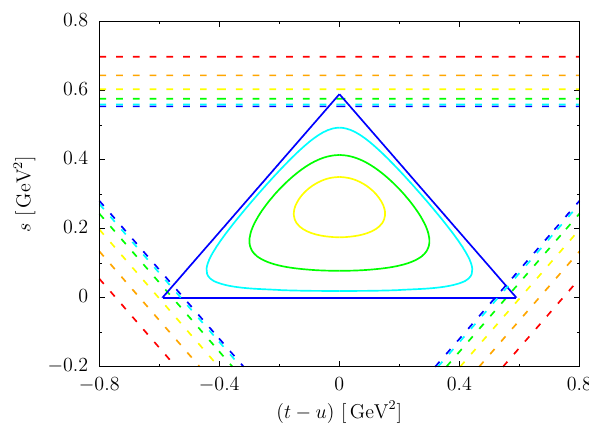
Fig. 5 Pion-mass-dependent decay width for ω → 3 π shown for three differentcases:kinematiccontributiononly(black),considering2-body FSI(red),andfull3-bodyFSI(blue).Thephysicalpointismarkedbythe blackdiamond.Theerrorbandsaregeneratedbytakingtheuncertainties of the IAM phase shift δ( s ) and M ω ( M 2 π ) into account, see Fig. 2 and Eq. (38)